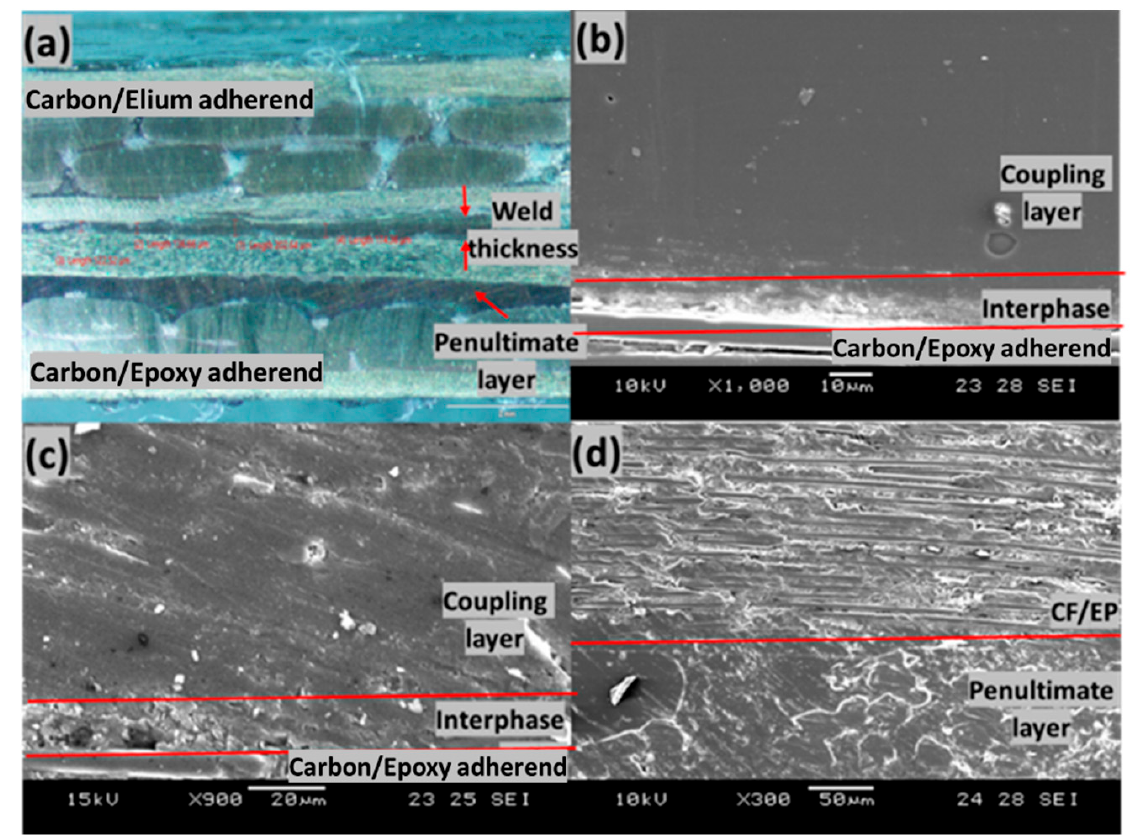
Figure 17. Cross-section of EL-EP(Elium ® -Epoxy)_0.25_0.25. ( a ) Overall view, ( b ) top layer of unwelded epoxy adherend, ( c ) top layer of welded epoxy adherend, ( d ) penultimate layer of welded epoxy adherend.